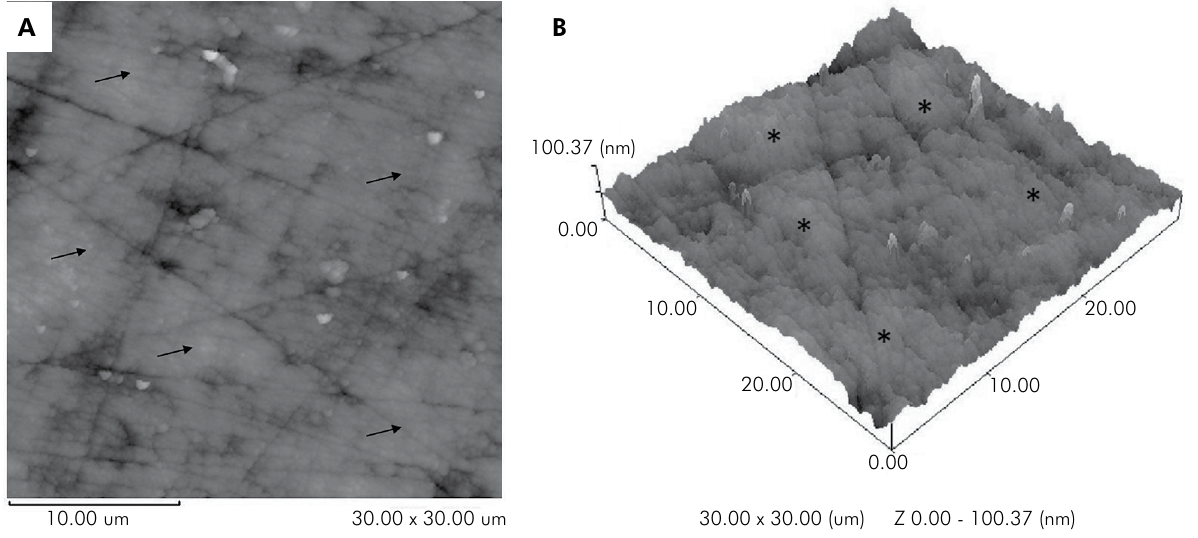
Figure 2. AFM image of enamel surface after NaF varnish application and erosive challenge. (A) ( → ) Interspersed globular deposits on surface. (B) *Enamel surface partially covered by a layer of globular